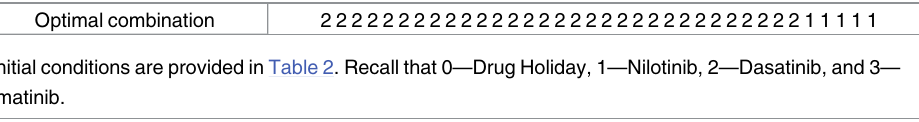
Table 3. Optimized treatment schedule for preexisting M351T. Optimal combination